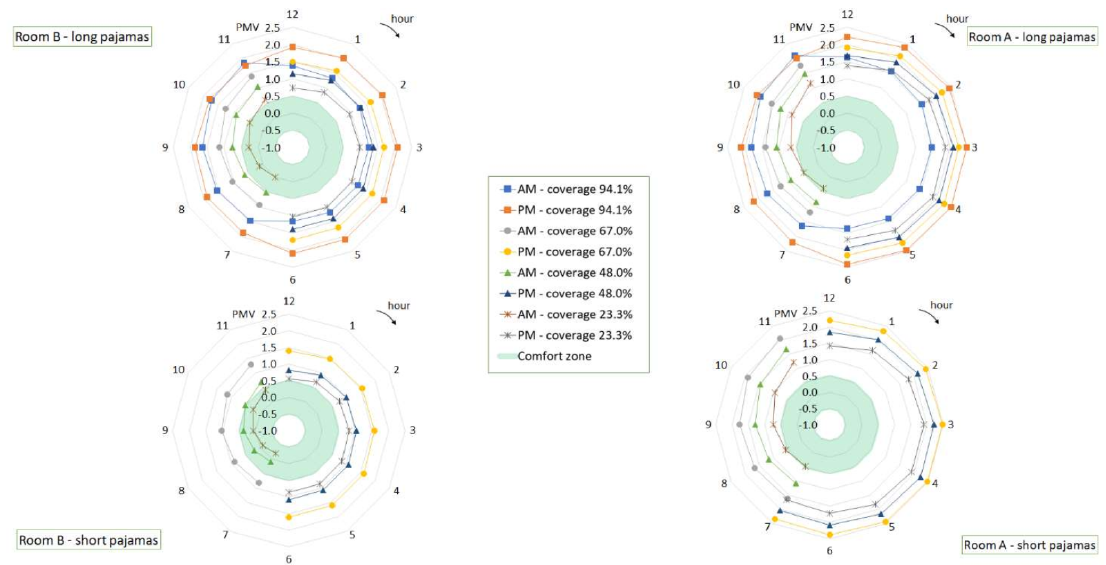
Figure 14. Hourly PMV of bedridden patient: different coverage rate and clothing in the autumn day. Considering the trend of T o and RH in Figure 15, it can be seen that during the night, in the early hours (19:00–23:00), T o was around 27.0 ◦ C in room B and 29.0 ◦ C in room A, with an RH ranging 75–77% in room B and 68–72% in room A. This implies that any combination of clothing and cover in the early hours of the night is highly unacceptable, resulting in a perception going from “slightly warm” to “warm”, especially in south exposed rooms (room A). After 23:00, there was a progressive decrease in RH and T o ; therefore, the PMV decreased, but the thermal discomfort sensation persisted if the level of coverage was